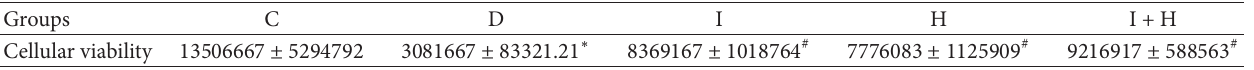
Table 2: The effects of insulin and honey on hippocampal neuronal cell viability (trypan blue